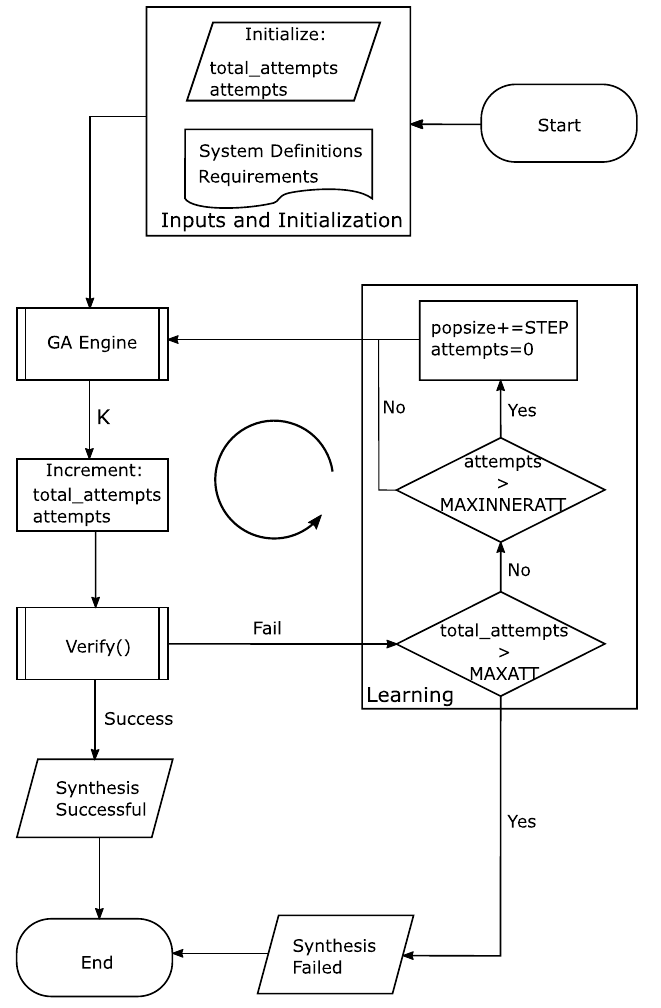
Figure 4. Proposed synthesis